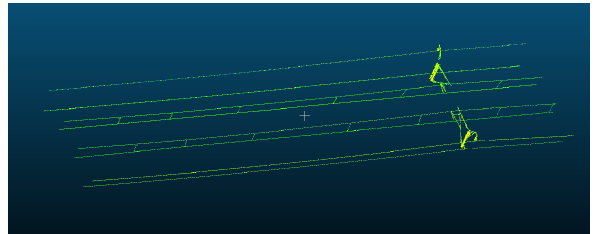
Figure 4. Result of significant point cloud segmentation